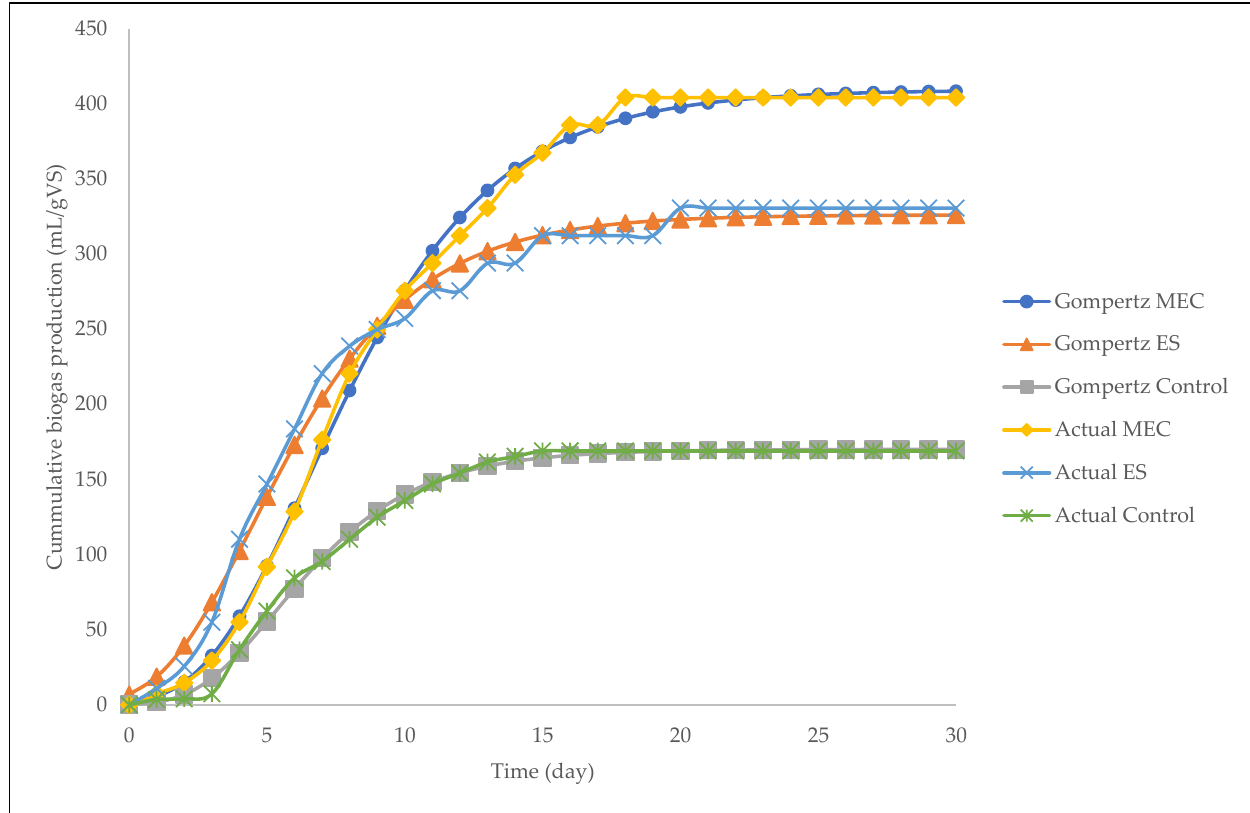
Figure 3. The modified Gompertz models versus actual cumulative biogas production for all di- Figure 3. gesters. all